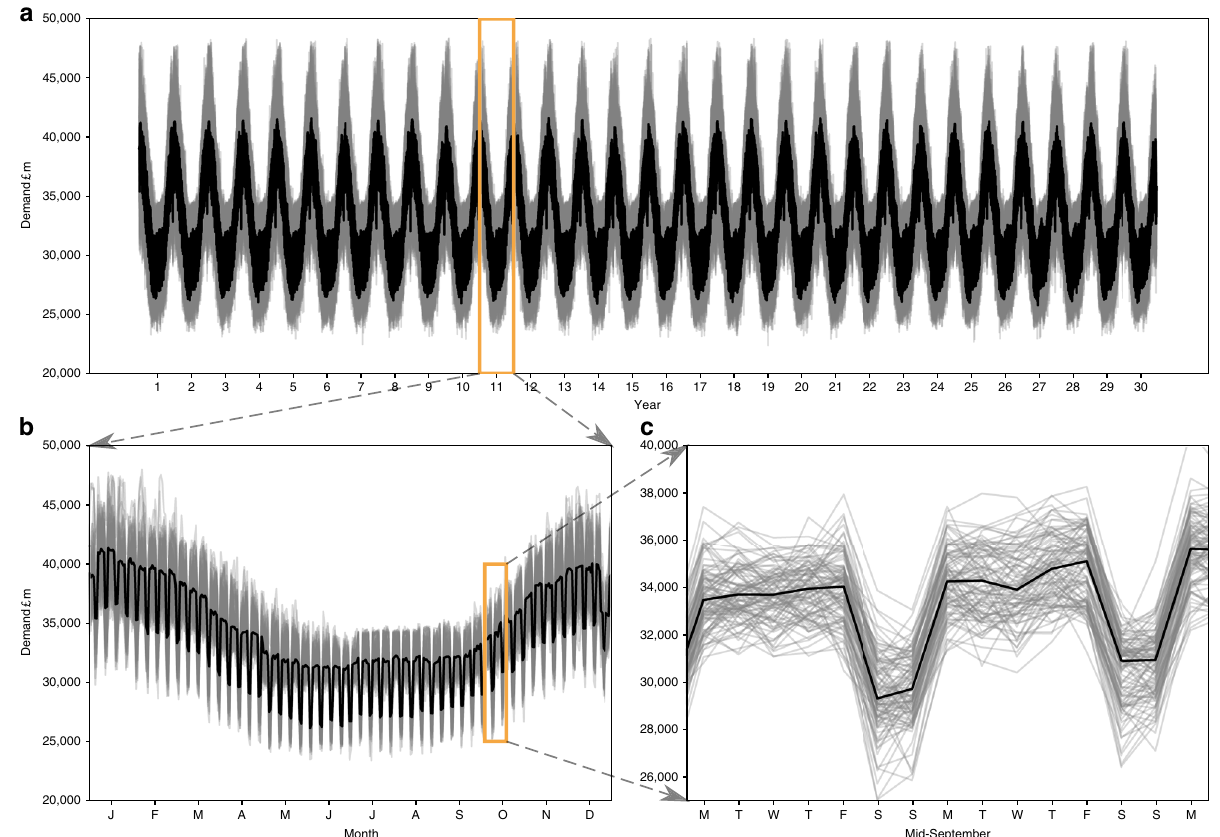
Fig. 9 Electricity demand timeseries for the baseline climate, using 100 W@H samples (grey), and the median in black. a The full 30-year timeseries. Lower panels zoom into the timeseries. b One-year pro fi le for year 10, months January through December. c Two-week pro fi le for year 10 in mid- September, Monday through